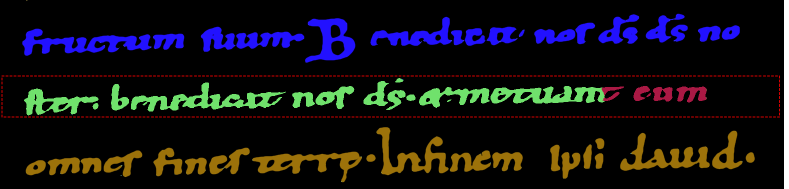
Figure 5. The red and green masks will be combined, because the red mask is completely contained within the horizontal section of the green mask (the dashed red rectangle).